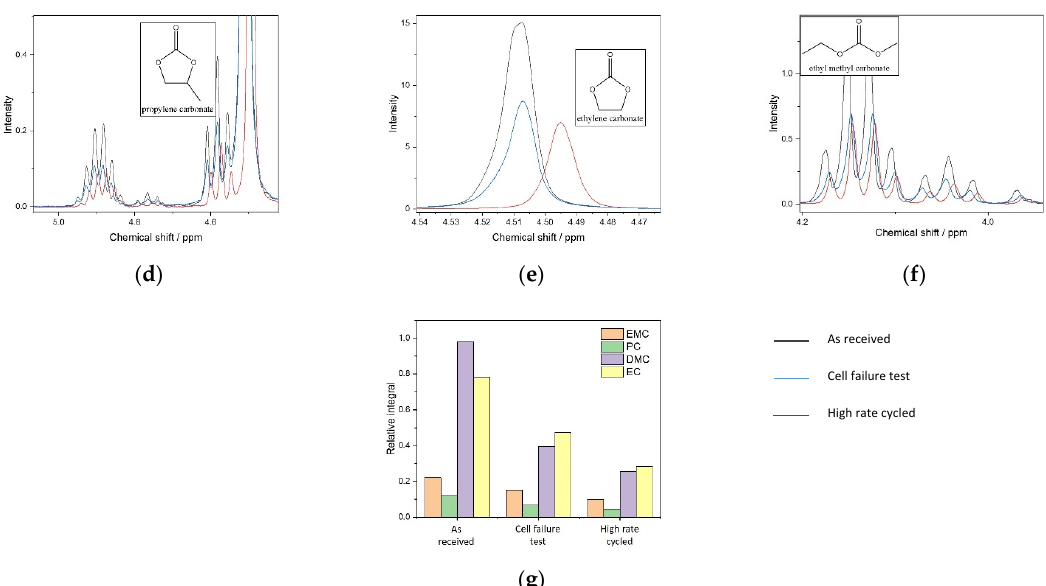
Figure 10. NMR spectra for as-received, cell failure test cell and high rate cycled cell. ( a ) solvent peaks of ethyl methyl carbonate and propylene carbonate ( b ) solvent peaks of succinonitrile ( c ) solvent peaks of dimethyl carbonate and ethylene sulfite ( d ) solvent peaks of propylene carbonate ( e ) solvent peaks of ethylene carbonate ( f ) solvent peaks of ethyl methyl carbonate and ( g ) the relative integral peaks of as-received, cell failure test cell and high rate cycled cell.